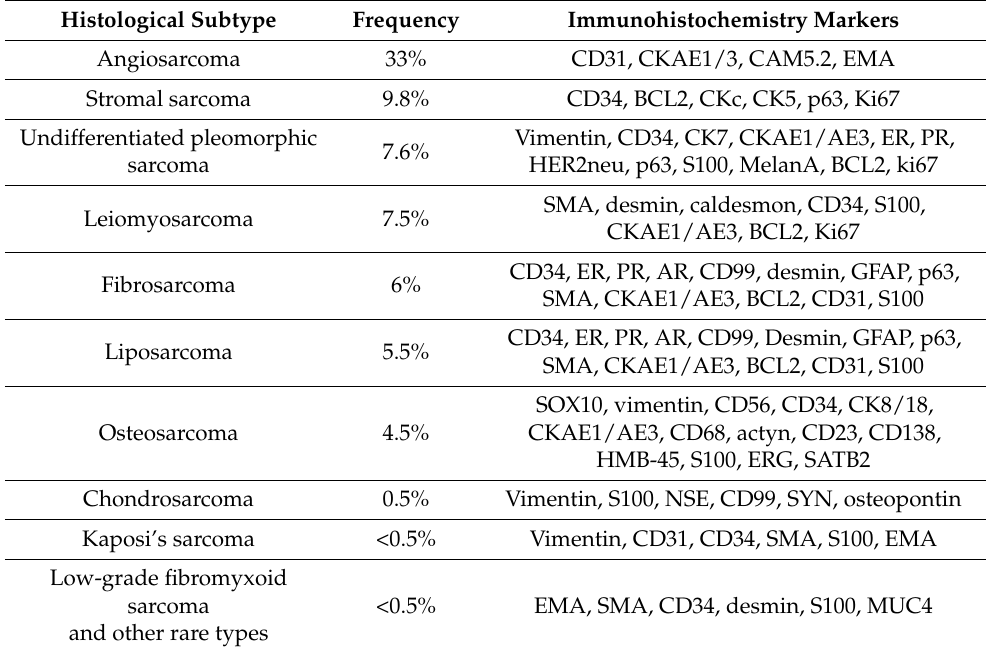
Table 5. Histological types of breast sarcomas in order of frequency, and IHC markers used to determine each type